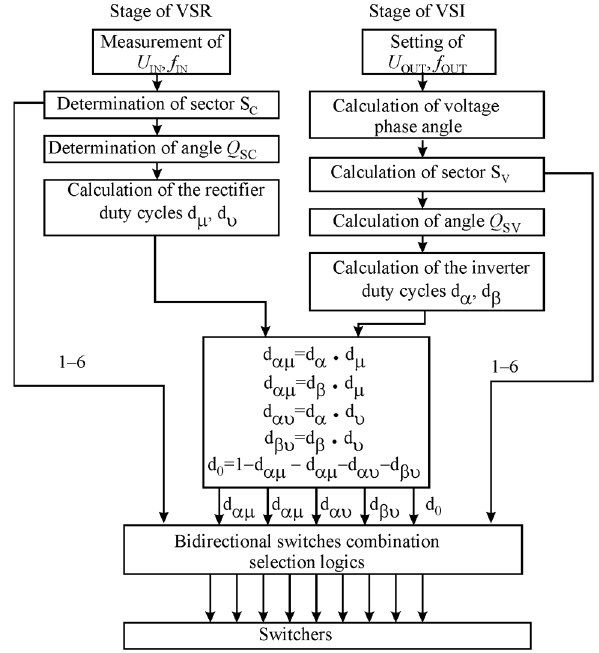
angle Q SC , and the input current displacement is determined by the angle Q SV .